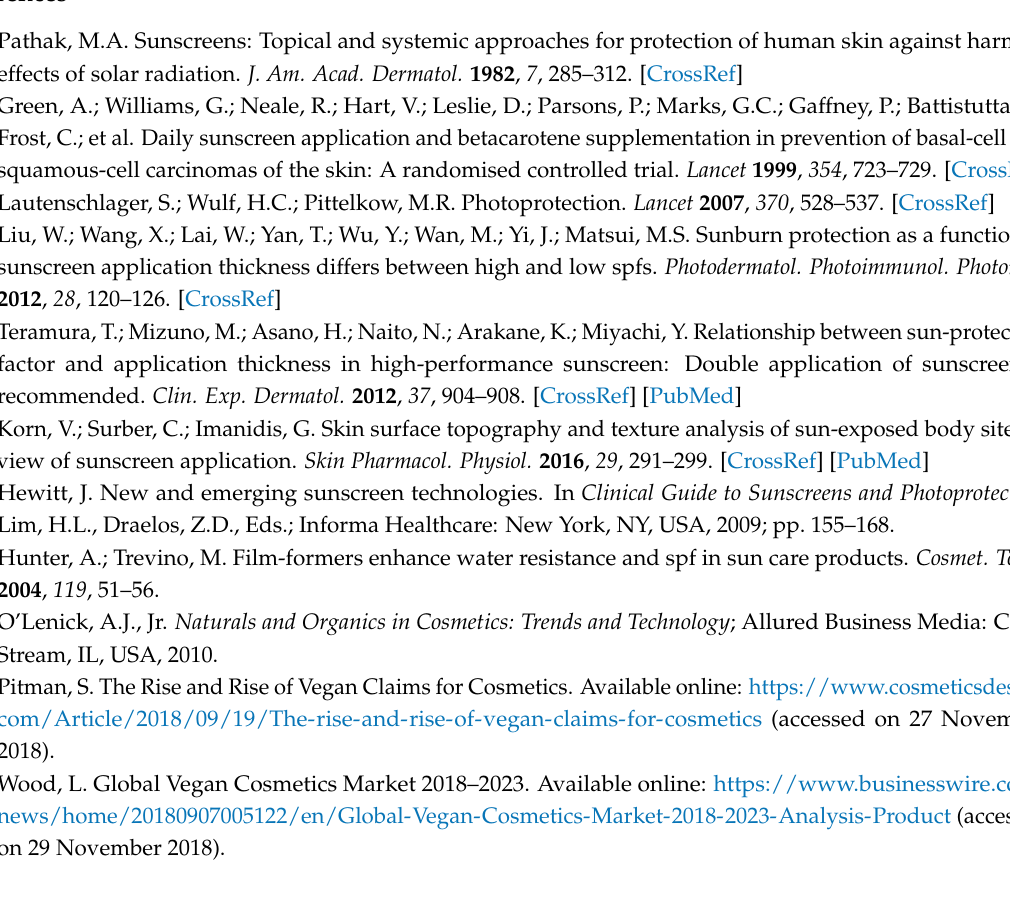
Table S1: pH of sunscreens and controls, Table S2: Stability results of